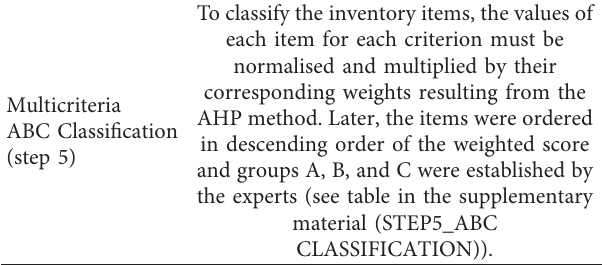
Table 11: Application of step 5 of the methodology (multicriteria ABC